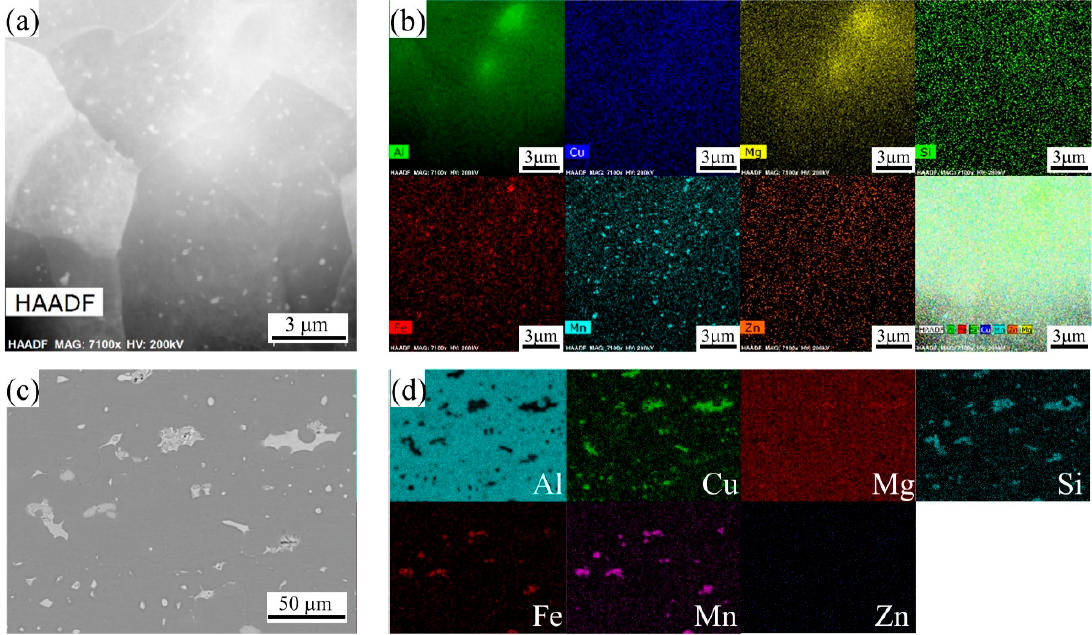
Figure 11. STEM images of 2A14 alloy after annealing to 555 °C: ( a ) HAADF image of the precipitates, ( b ) EDS mapping images of the main alloying elements; ( c ) SEM images of the 2A14 alloy, backscattered electron map and ( d ) the corresponding EDS mapping images of the main alloying elements.